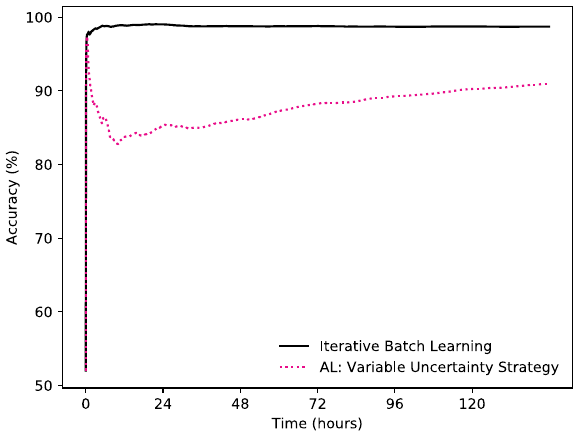
Figure 3. The accumulated accuracy for iterative batch learning vs. variable uncertainty strategy. Table 1. The accumulated accuracy and F1-score for learning strategies in static